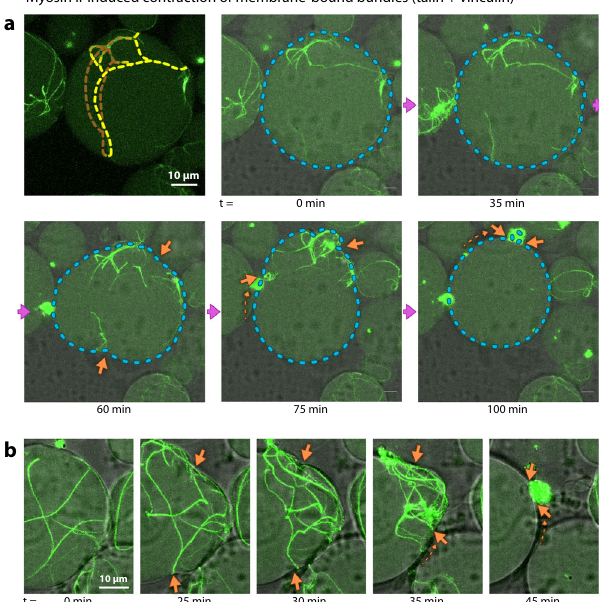
Fig. 5 Actomyosin contraction leads to membrane deformations. a Time series of a contracting ring-like structure in a GUV. Same conditions as in Fig. 4c but with 0.1 µ M myosin II. Only the midsection of the vesicle is shown, top and bottom are missing, but the yellow dotted lines in the fi rst frame show the approximate position of the bundles (see also Supplementary Fig. 13). Cyan dotted lines in the following frames indicate the outline of the vesicle. Orange arrows indicate membrane deformations (vesicle constriction). The partially visible vesicle on the left can be seen to undergo a similar transition from a large actin network ( t = 0) to myosin- constricted cluster ( t = 60 min). Supplementary Movie 6 shows the same fi eld of view. b Additional example of large-scale vesicle deformation through actomyosin contraction. Even though no furrow-like deformation was observed, the contraction of actin bundles still causes large-scale vesicle deformations (orange arrows).